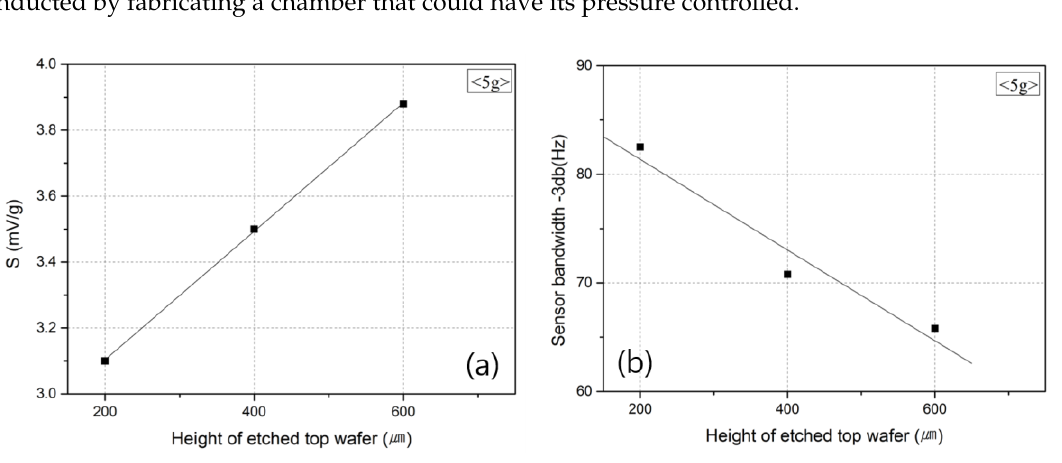
Figure 9. Output ( a ) sensitivity and ( b ) frequency of the accelerometer according to the height of the etched top wafer.